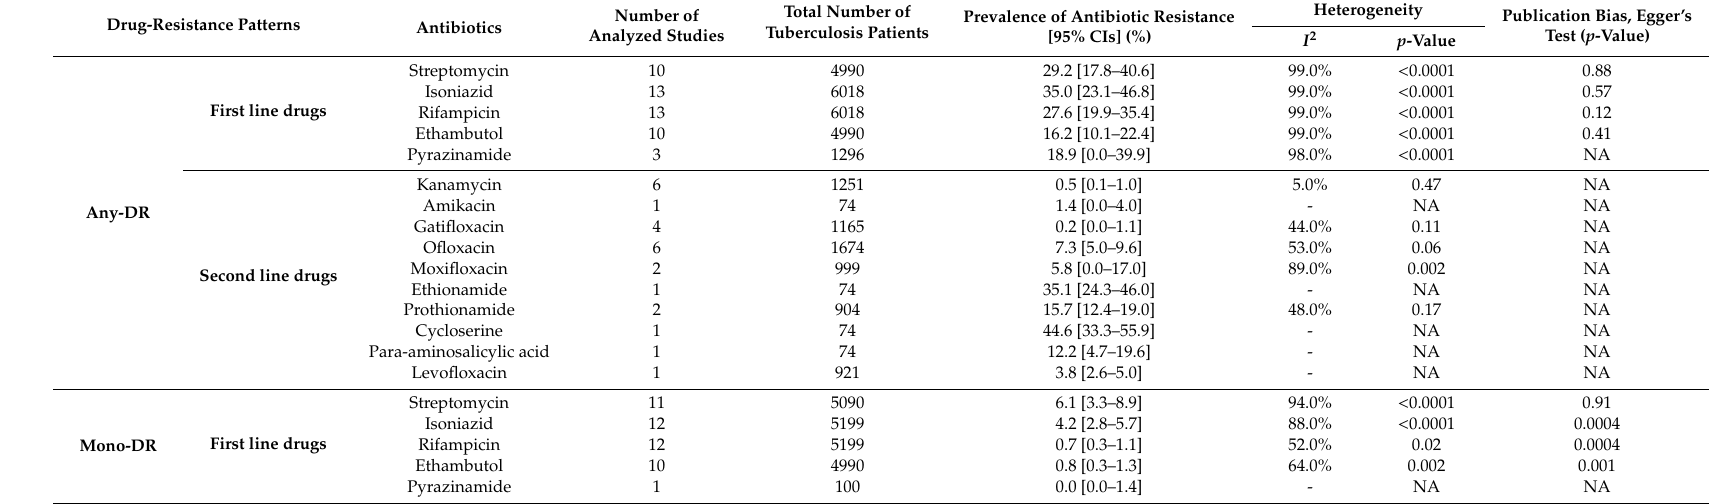
Table 2. Any and mono anti-tuberculosis-DR patterns in